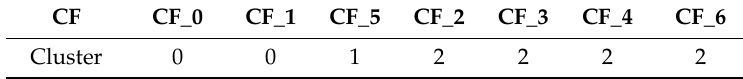
Table 7. Results of the Labels of Contextual Fragments’ Clustering.